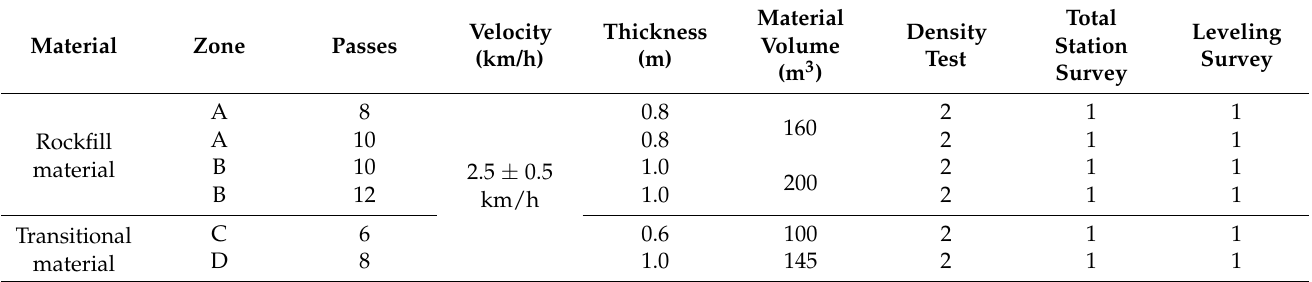
Table 2. Rolling test